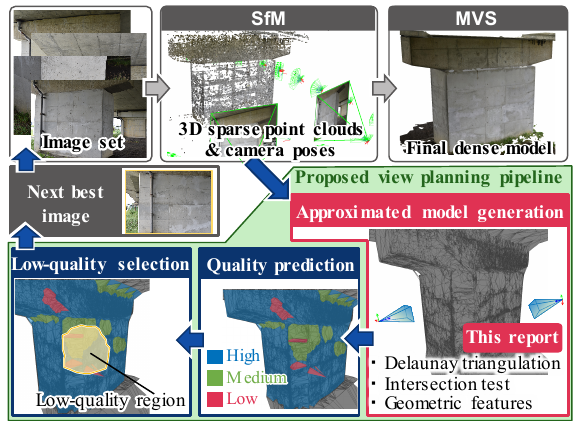
Figure 1. Outline of our view planning system for SfM–MVS (Moritani,